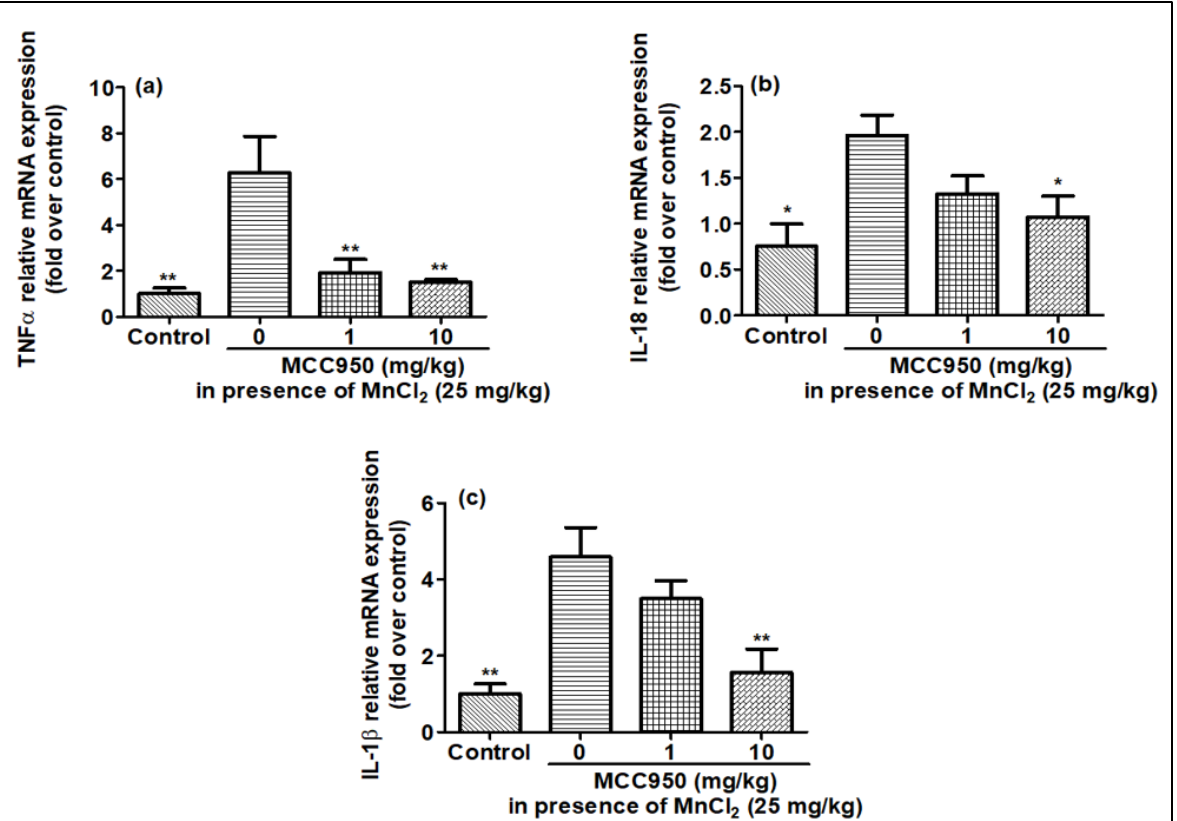
Figure 10. mRNA expression for pro-inflammatory cytokines was elevated by MnCl 2 exposure and inhibited in a gradual dose-dependent manner by MCC950 in rat brain samples evaluated by qPCR. ( a ) relative TNFα gene expression, ( b ) relative IL-18 gene expression, ( c ) relative IL- 1β gene expression. All mRNA values were normalized to the housekeeping mRNA, GAPDH, and expressed as a fold-induction over the control sample (set at a value of 1). Data represented as mean ± SEM. * p < 0.05, ** p < 0.001 vs. control group.